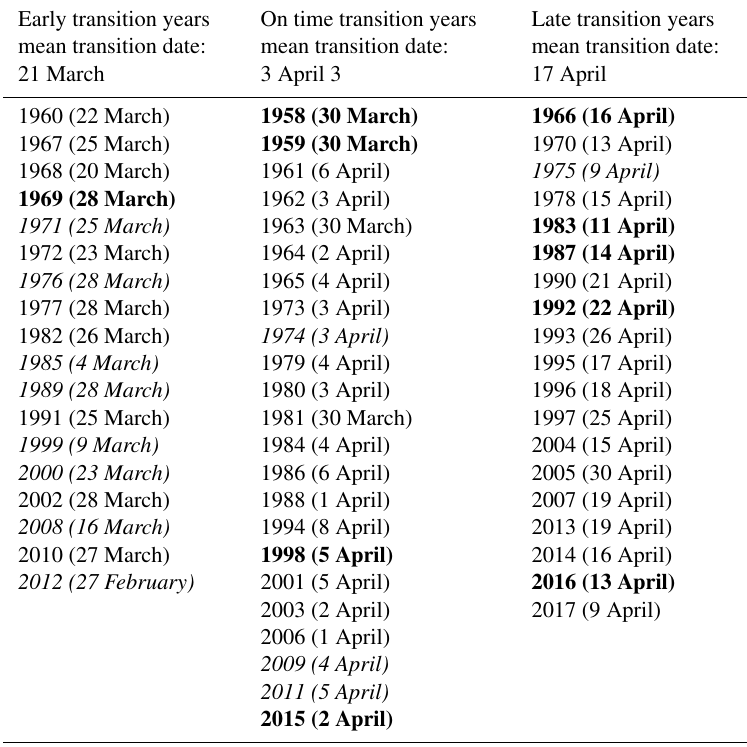
Table 1. Years when the jet transitioned early, on time, or late, relative to the mean transition date of 3 April. Italic (bold) text denotes years when La Niña (El Niño) conditions were observed the month of the transition